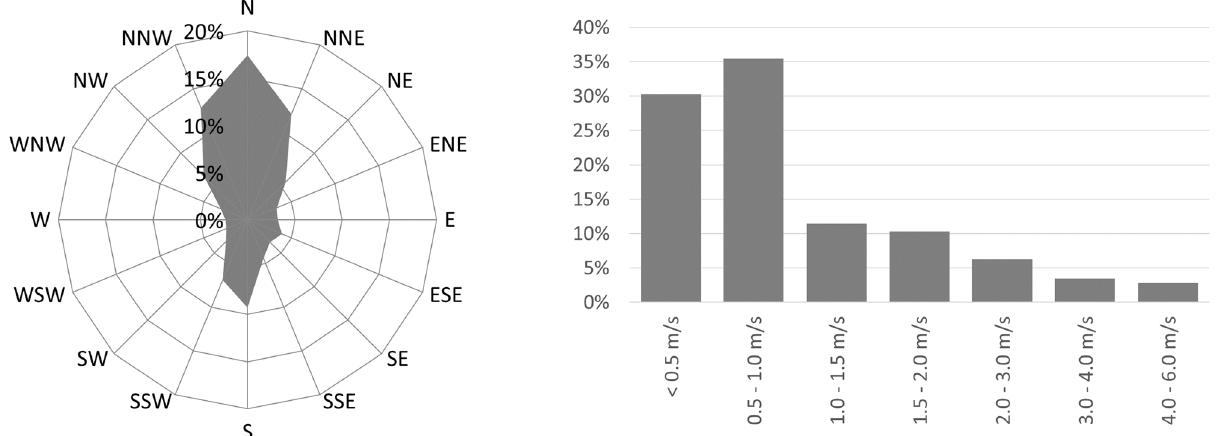
Figure 3. Observed wind-direction and wind-speed frequencies averaged over the period of the field inspections (10 January–12 July 2022).